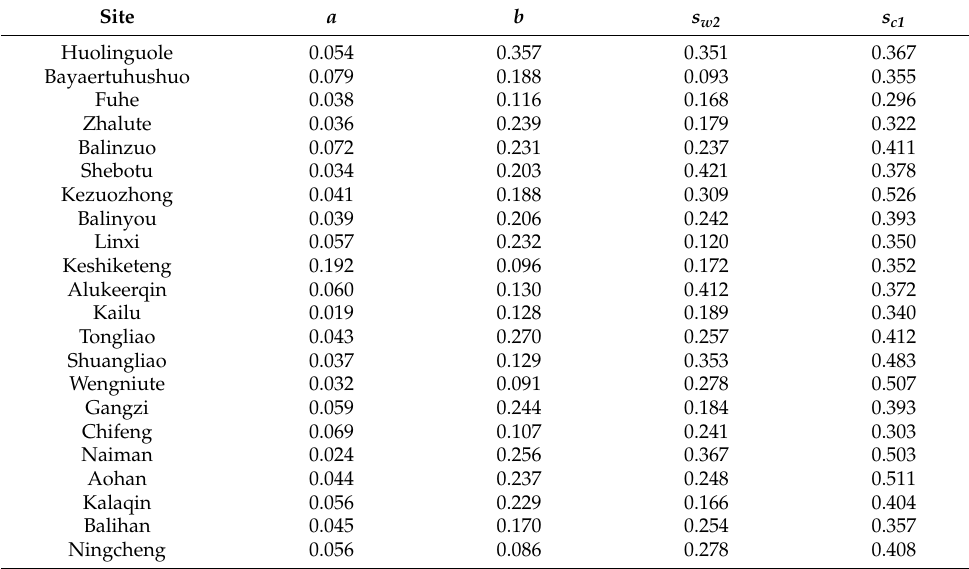
Table 1. Calibrated SMAR parameters at pixels where in-situ sites were